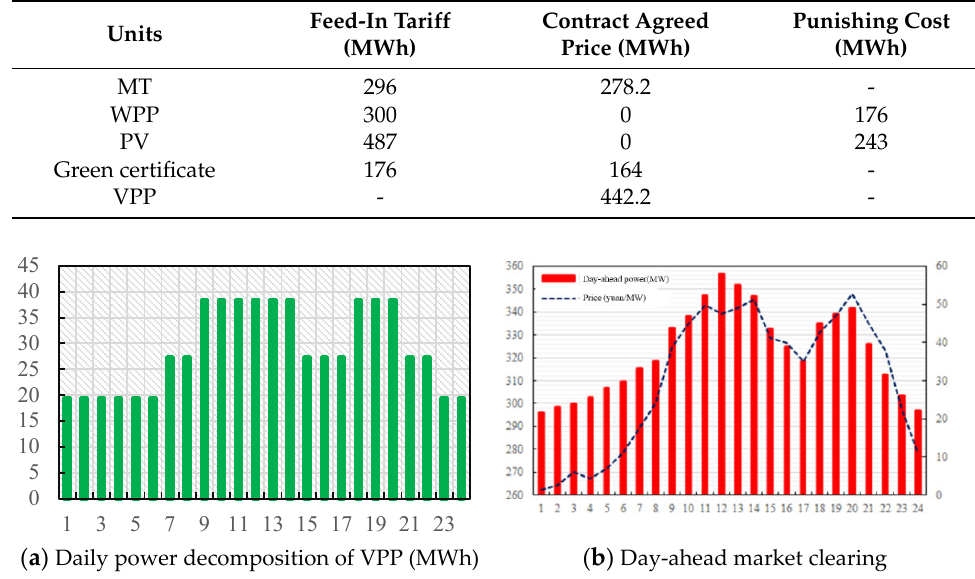
Table 2. Unit price setting of VPP (Yuan).